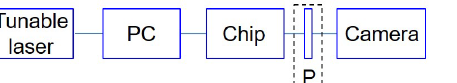
Figure 8. Diagram of the chip testing system. PC: polarization controller. P: polarizer.